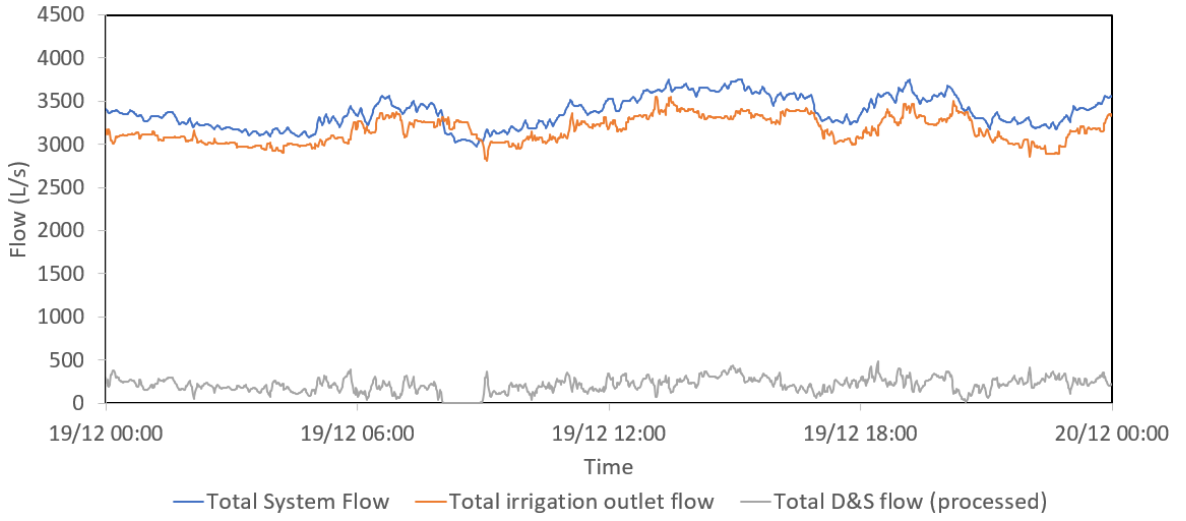
Figure 4. Total flow of each demand category during the validation period.